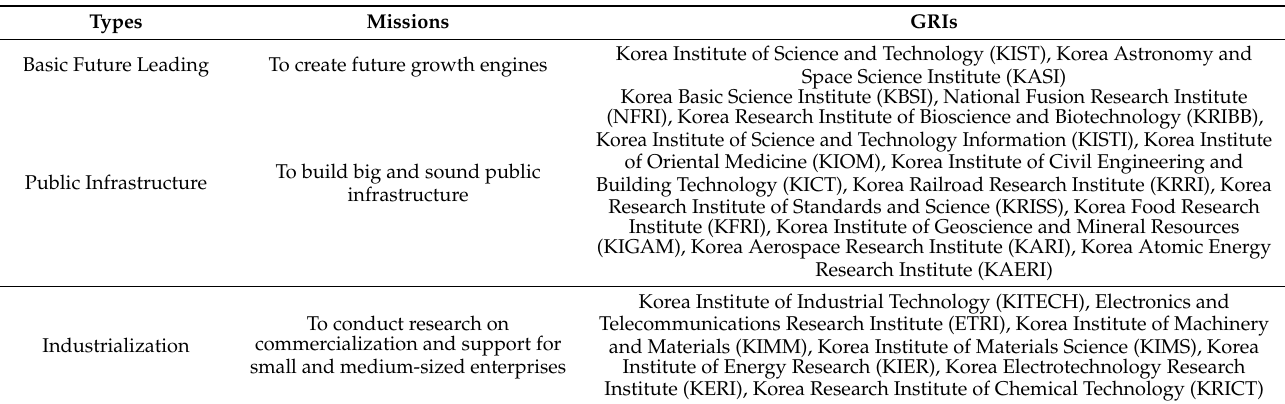
Table 1. Three mission types of